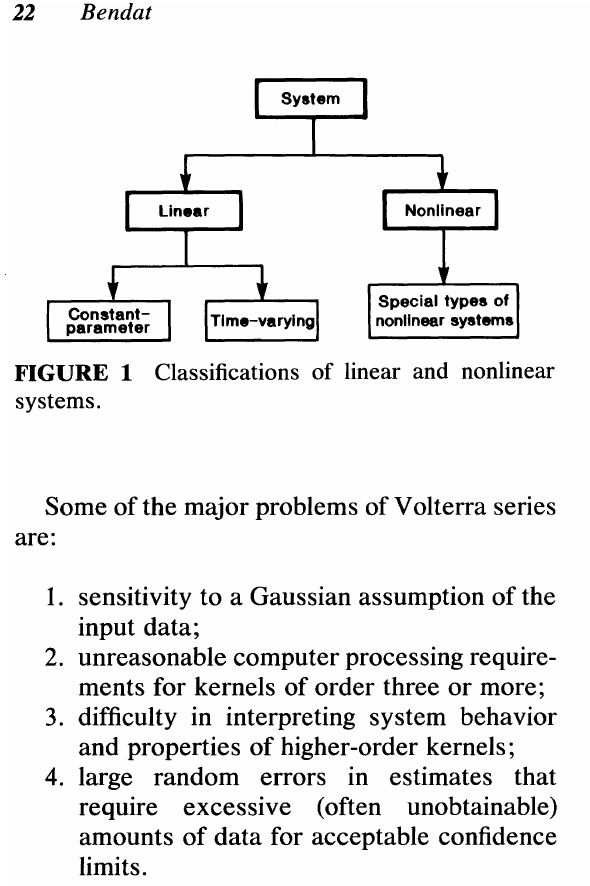
FIGURE 1 Classifications of linear and nonlinear